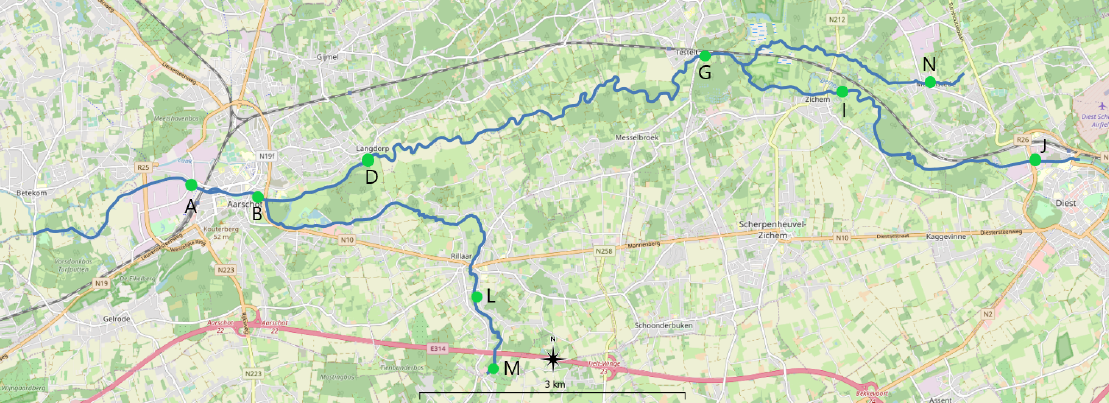
Figure 3. The part of the Flemish river system used in the experiments. The green dots indicate the locations of the sensors . The letters beside the dots are the IDs of such locations. This map is realized with QGis ( qgis.org ) and OpenStreetMap ( openstreetmap.org ).